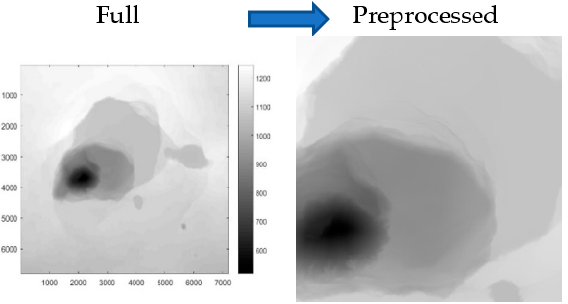
Figure 5. Shield caldera (K ī lauea, HI, USA) [64]: 1000 × 1000 with pixel size of 3 m.